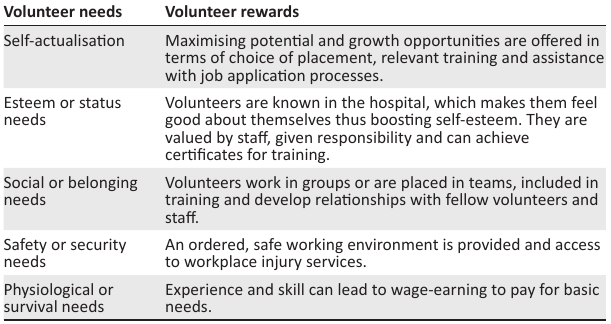
TABLE 1: Maslow’s motivational theory as applied to the volunteers experiences.